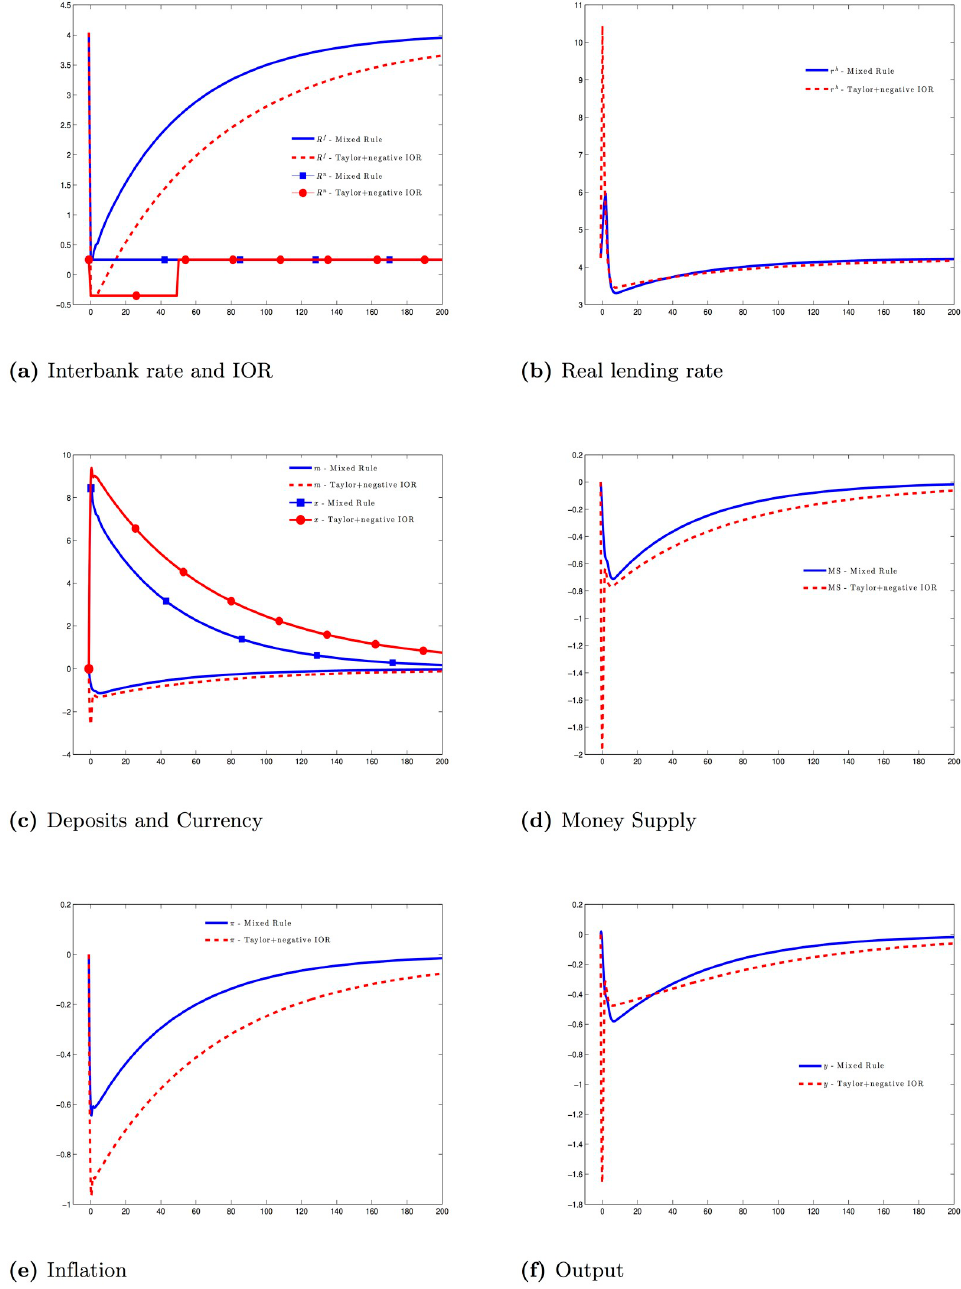
Fig 4. Financial crisis—Mixed rule (mixed rule—M5) and interest rate policy (Taylor+negative IOR—M3).